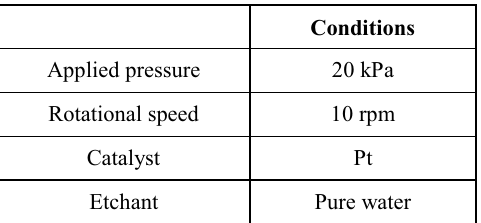
Table 1. The experimental conditions.